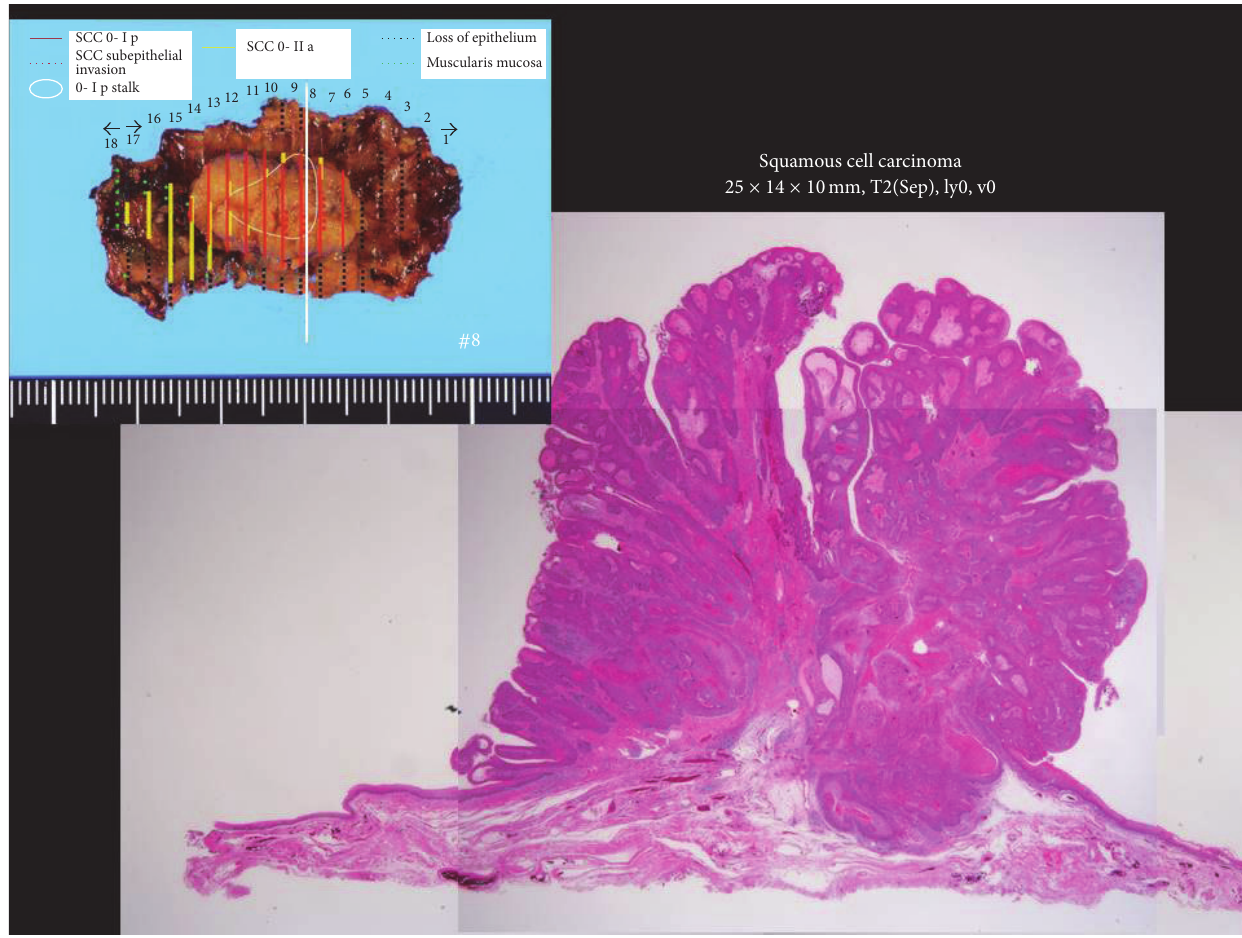
Figure 5: A histopathological examination revealed a diagnosis of invasive squamous cell carcinoma. A 25 × 18 × 10mm superficial lesion was removed by en bloc